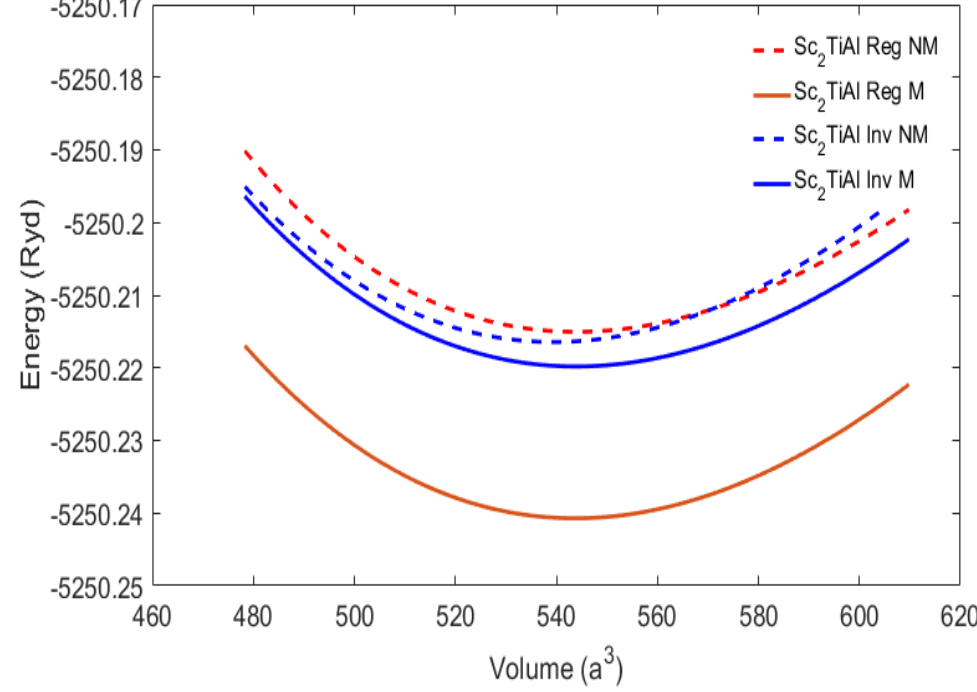
Figure 2. The total energy (Ry) versus volume (a.u 3 ) of non-magnetic, regular, and inverse Sc 2 TiAl Heusler.